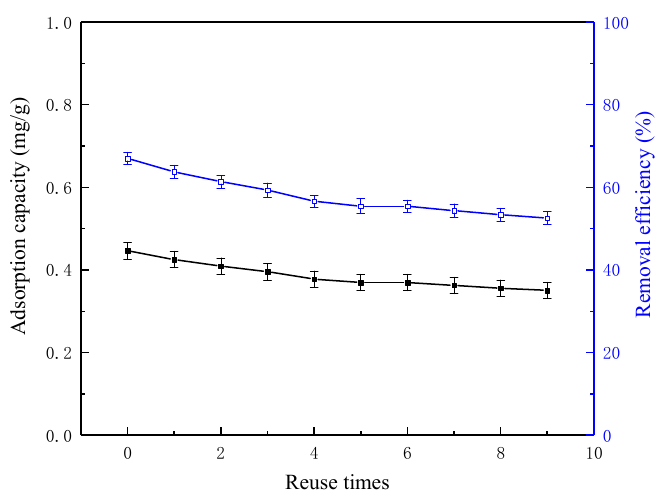
Figure 9. Relation between reuse times and pyridine removal efficiency and adsorption capacity of pyridine.